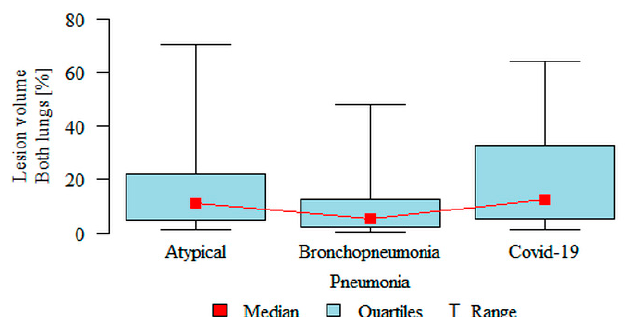
Figure 3. Comparison of the volume of inflammation (“lesion”) as a percentage of the volume of both lungs, in three subgroups of pneumonia.